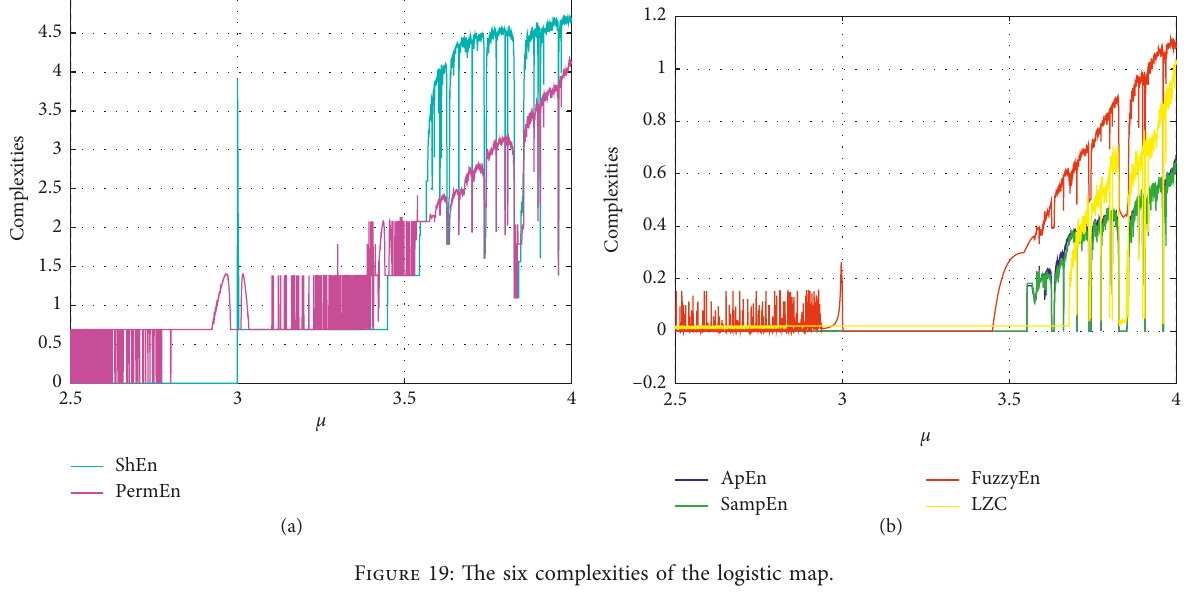
Figure 19: The six complexities of the logistic map.